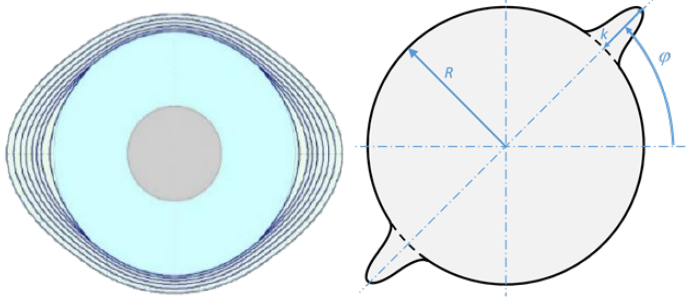
Figure 3. Illustration of planar delamination propagation (left) and propagation in a single trans- verse direction (right) [45]. direction (right)